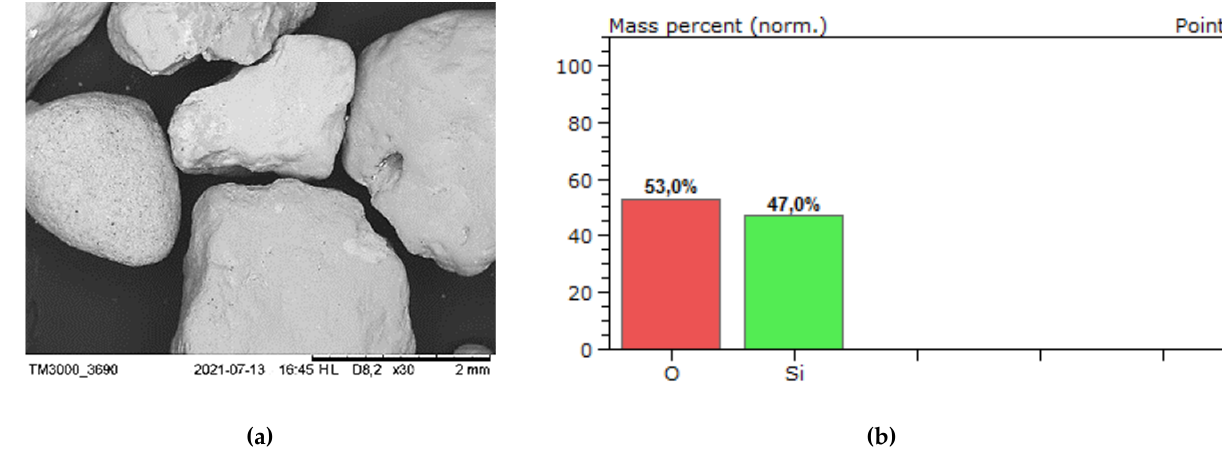
Figure 4. (a) Natural aggregate (A NS ) grains—magnification of 30×; (b) identification of the elements. Figure 4. ( a ) Natural aggregate (A × ; ( b ) identification of the NS ) grains—magnification of 30